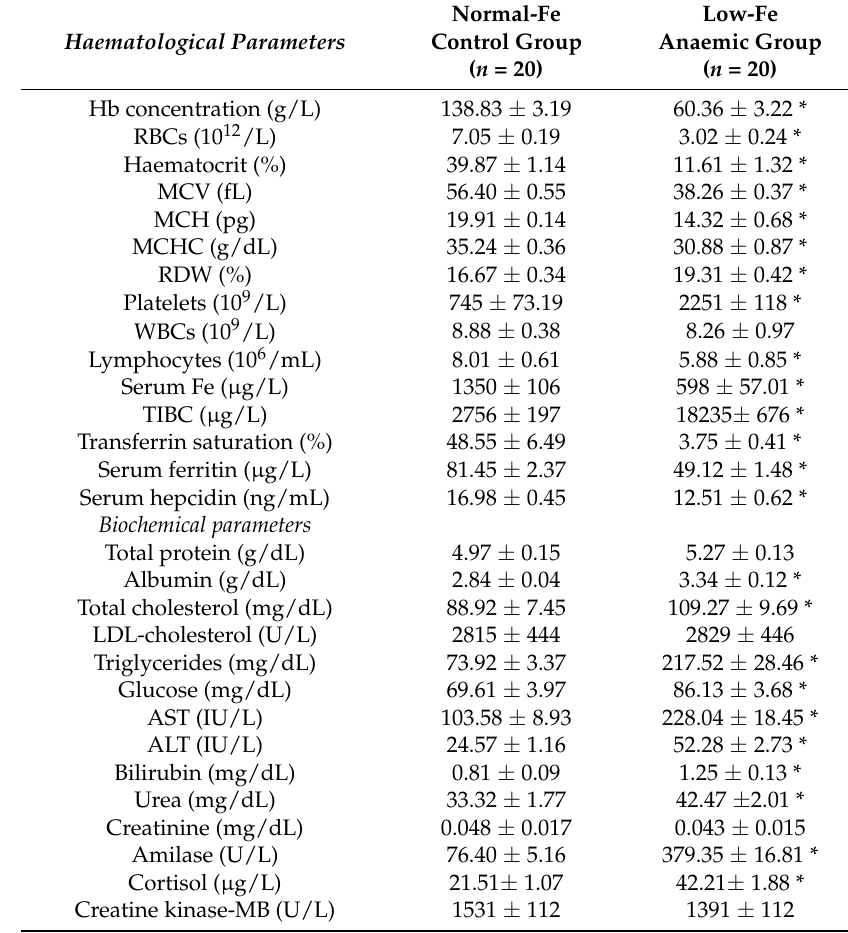
Table 2. Haematological and biochemical parameters of control and anaemic rats.